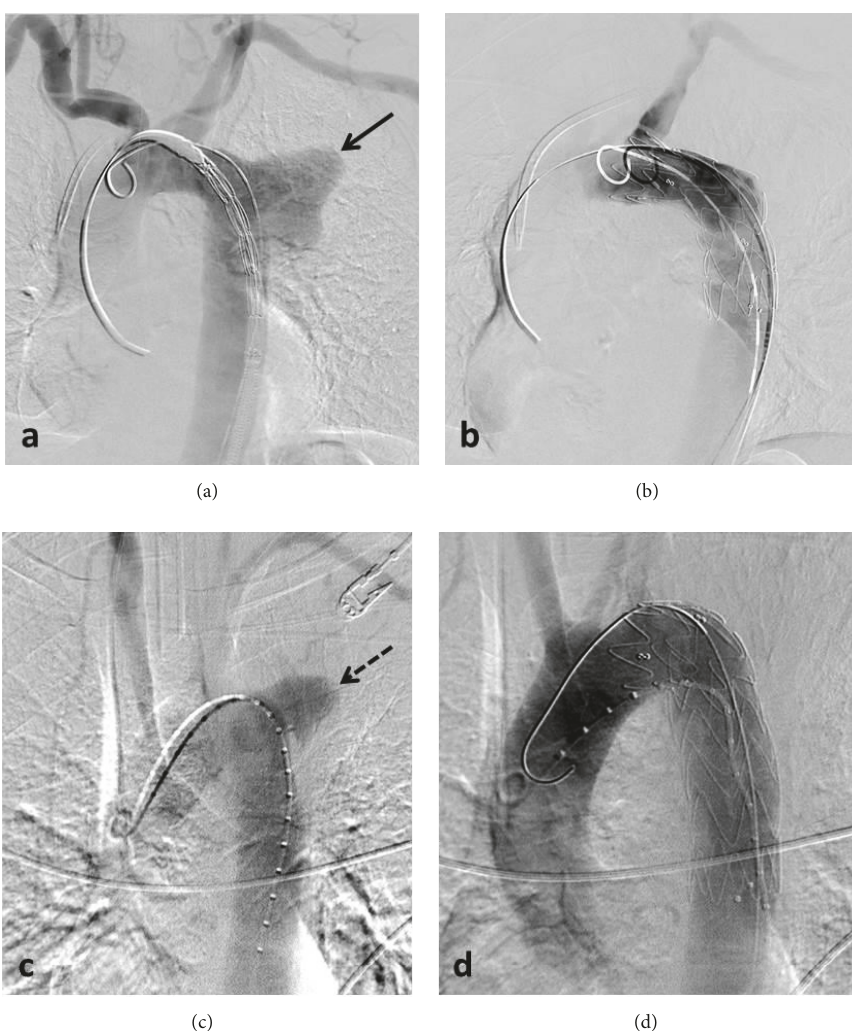
Figure 2: Case 1 (a, b). Case 2 (c, d). Intraoperative digital subtraction angiography images show saccular wide neck aneurysms located proximal to the descending thoracic aorta (black arrow in (a), dashed arrow in (c)) with complete exclusion of the aneurysms after stent-graft deployment (b,